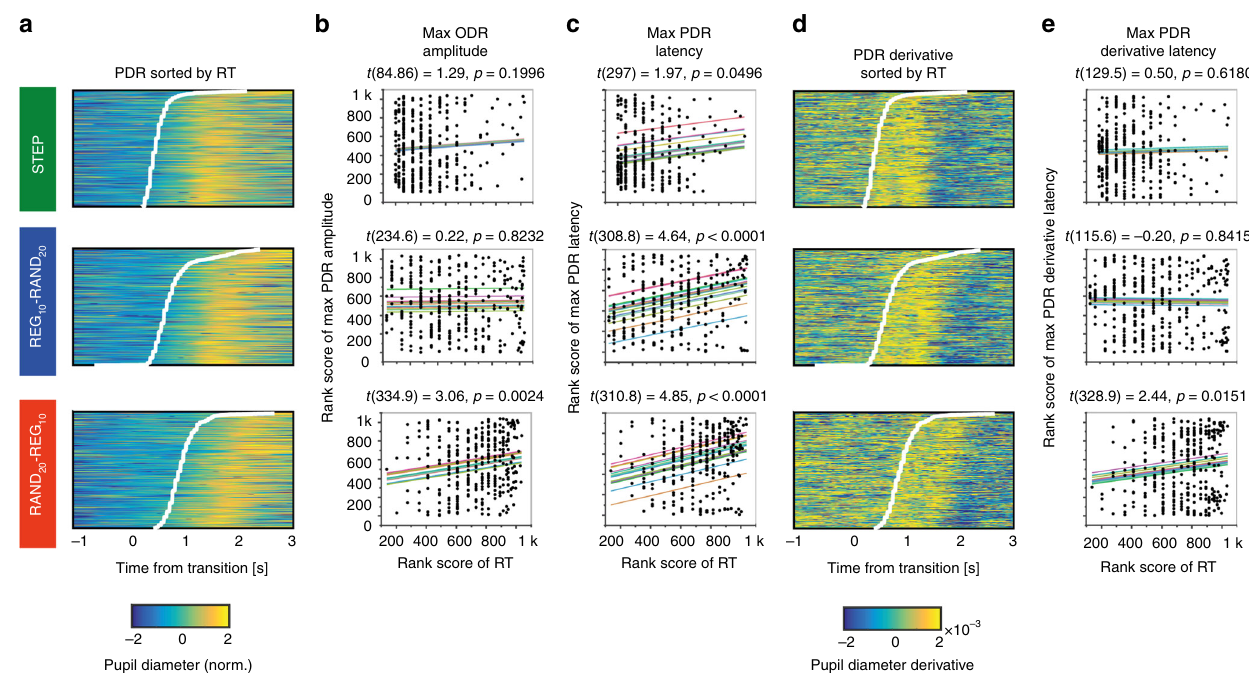
Fig. 7 Relationship between RT and the pupil dilation response. a Single trials sorted by RT ( y -axis, RT indicated by white lines) shown against the time relative to the transition ( x -axis) with the colors showing pupil diameter (the warmer the color, the larger the pupil). b Scatter plots show the maximum PDR amplitude for each trial (ranked low to high on the y -axis) versus ranked RT (smaller values faster) for the same trial ( x -axis), separated by condition as in a . Each line of fi t shows the modeled random effect of subject (offset), with slope the fi xed effect of RT. Fixed-effects t -values and associated p -values appear above each fi tted scatterplot. c Rank maximum PDR latency vs. RT. Scatterplot and fi tting as in b . d Single trials sorted by RT ( y -axis, RT indicated by white lines) shown against the time relative to the transition ( x -axis) with the colors showing the rate of change of pupil diameter (the warmer the color, the larger the rate of change in pupil size). e Rank maximum derivative latency vs rank RT (scatterplot fi ts as in c